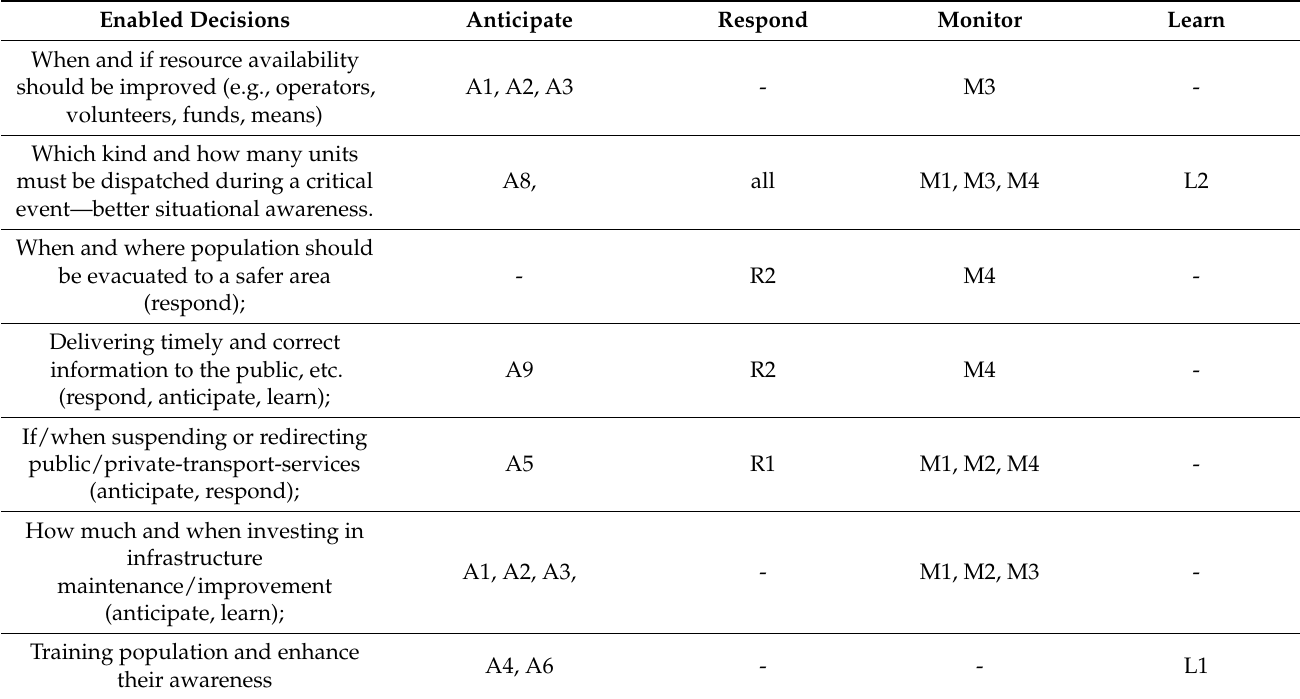
Table 2. Enabled decisions–functions